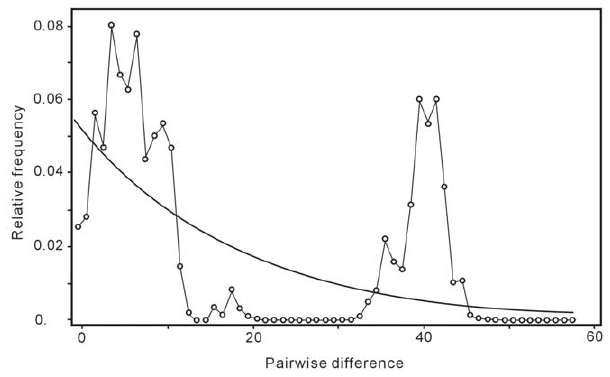
Figure 2. Mismatch distribution of the number of difference between all possible pairs of haplotypes. Comparison between the empirical distribution ( q — q ) and the expected distribution (—) under expansion